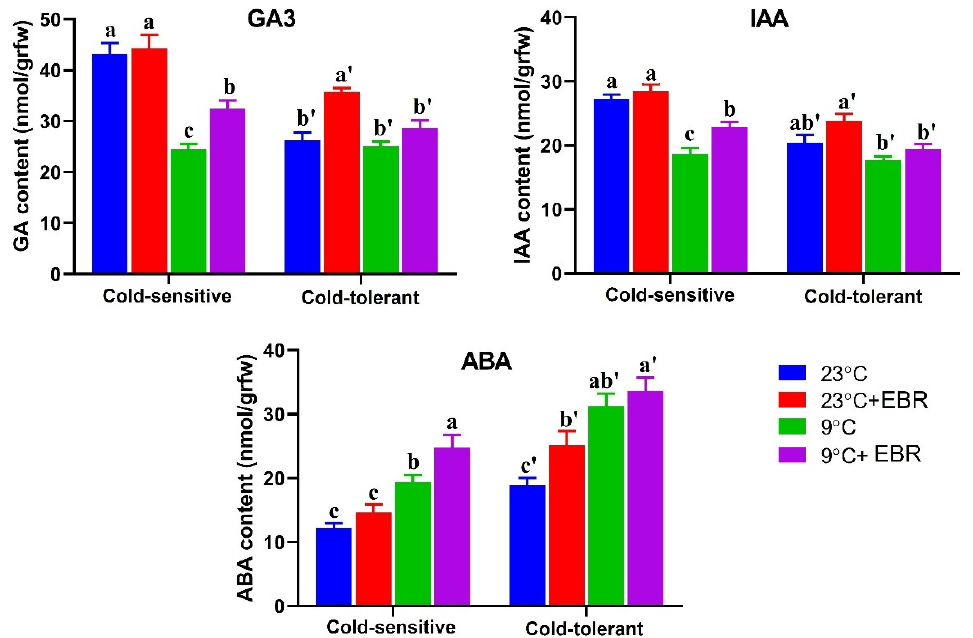
Figure 1. Profile of hormone content (in nanomoles per gram fresh weight (nmol/grfw)) of tomato leaves in response to temperature change and EBR application. Different letters above a bar show significant difference according to the Tukey’s range test at p < 0.05.